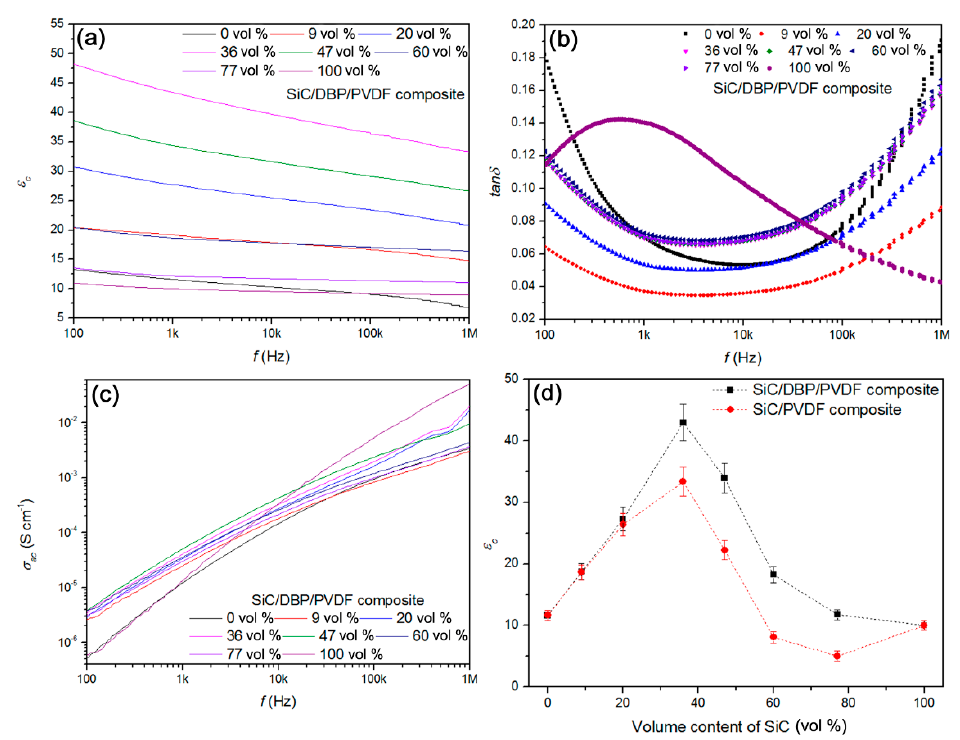
Figure 5. ( a ) Increase of dielectric constant for the ternary composites via blend strategy; ( b ) lower low-frequency loss for the ternary composites compared with PVDF matrix; ( c ) AC conductivity results show the fine insulating property for all of the ternary composites; and ( d ) dielectric constant at 1 kHz shows “^” trend for the binary and ternary composites with the increase of SiC volume content.